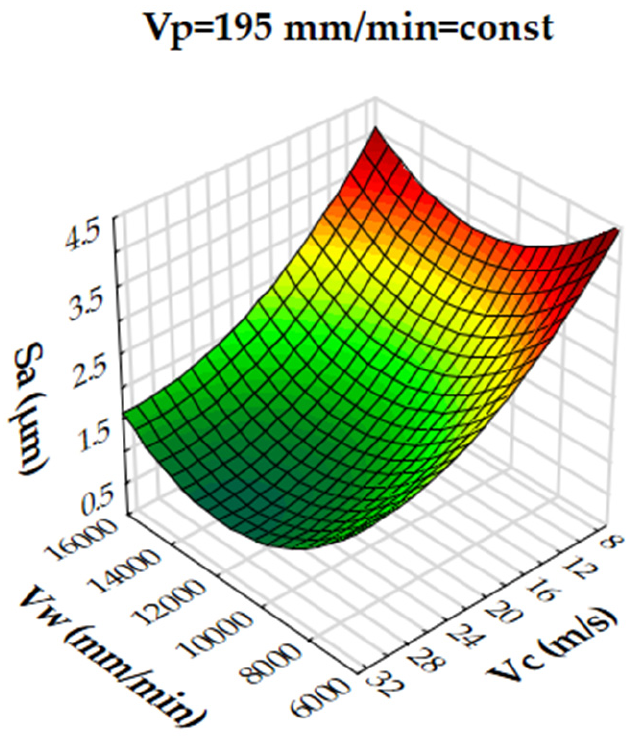
Figure 8. Dependence of roughness, Sa, on longitudinal feed rate, Vw, and cutting speed, Vc, for a multigranular wheel (constant Vp). Figure 9. Dependence of roughness, Sa, on transverse feed rate, Vp, and cutting speed, Vc, for a conventional grinding wheel (constant Vw).